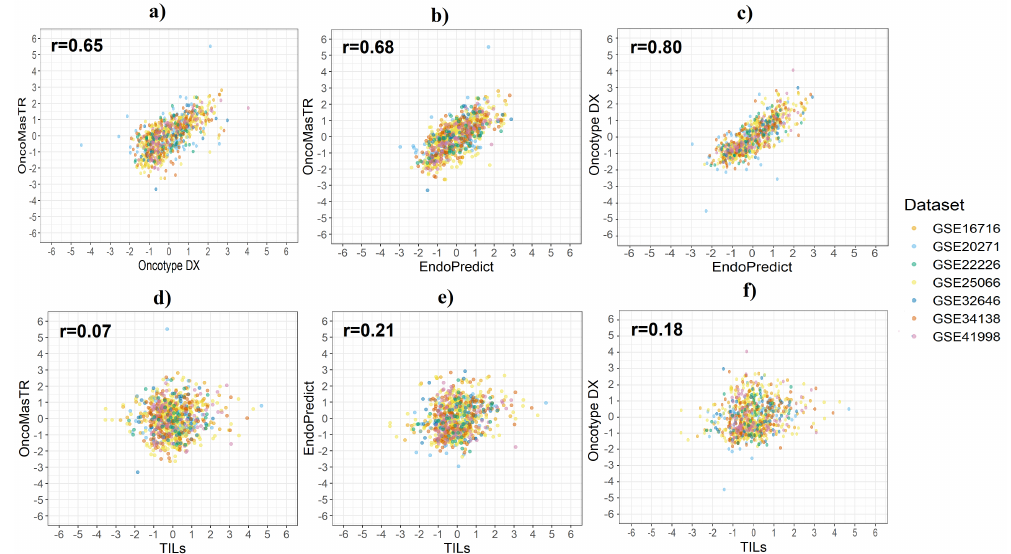
Figure 2. Correlation between risk scores by dataset. ( a ) OM vs. RS; ( b ) OM vs. EP; ( c ) RS vs. EP; ( d ) OM vs. TILs; ( e ) EP vs. TILs; ( f ) RS vs.